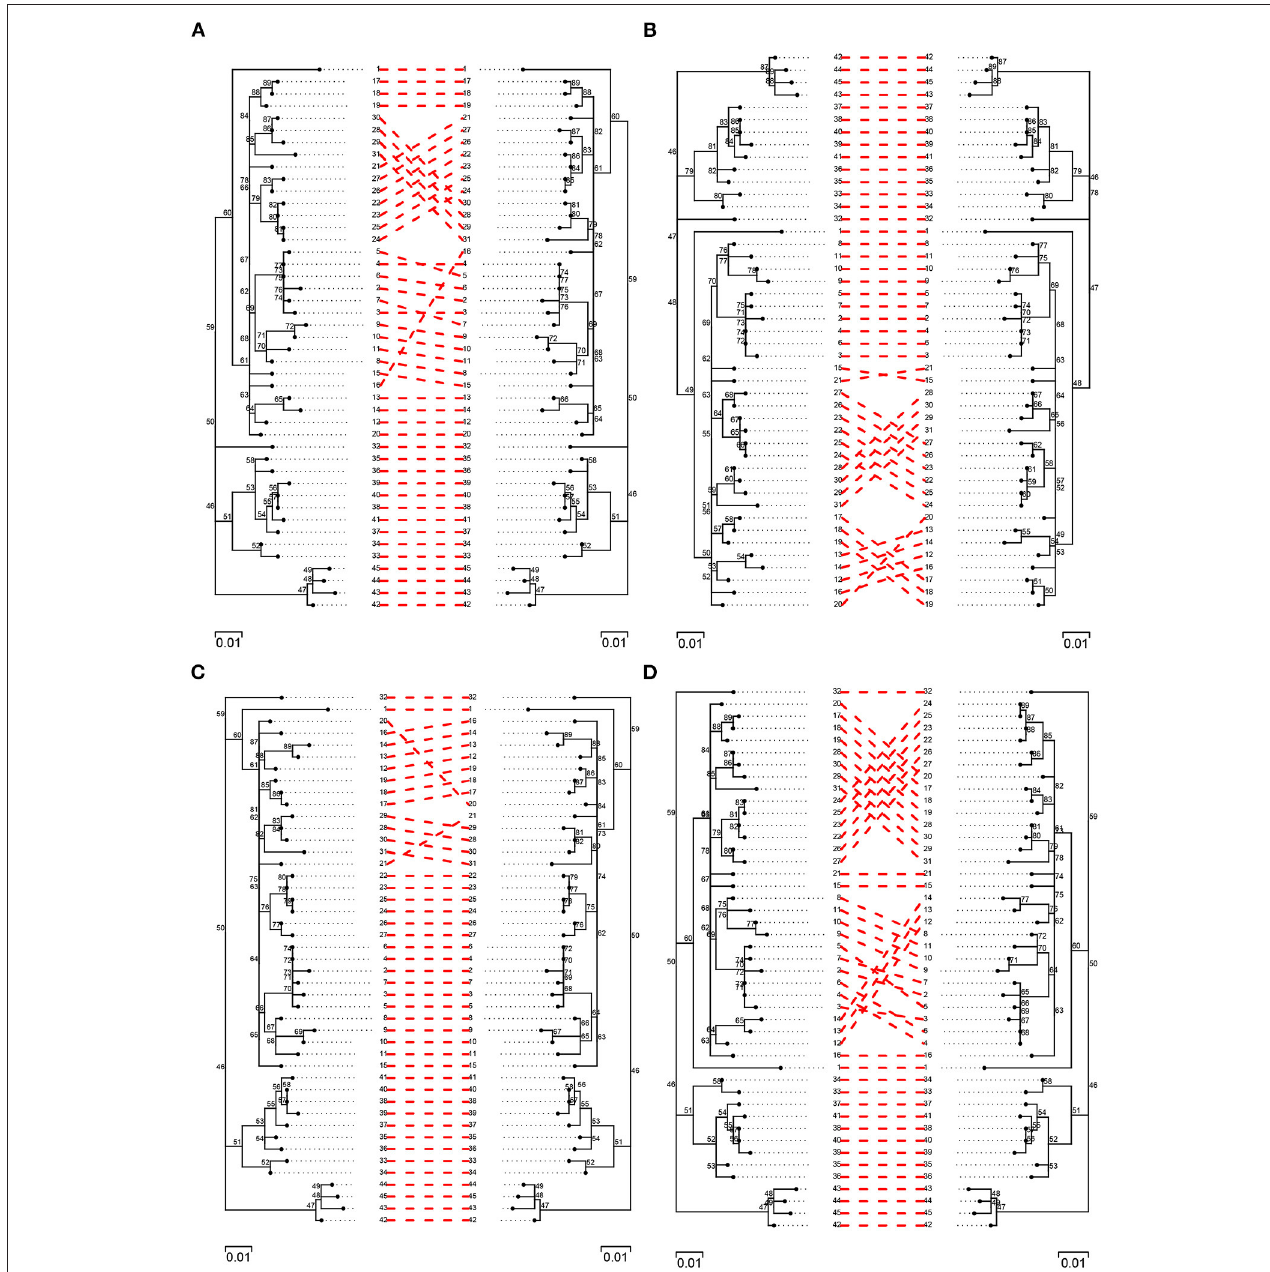
FIGURE 6 | Pairwise comparison of filtered (filter F) simulated trees (left) and trees obtained from the evaluated pipelines (right): (A) vSNP, (B) SNiPgenie, (C) BovTB, and (D) MTBseq.